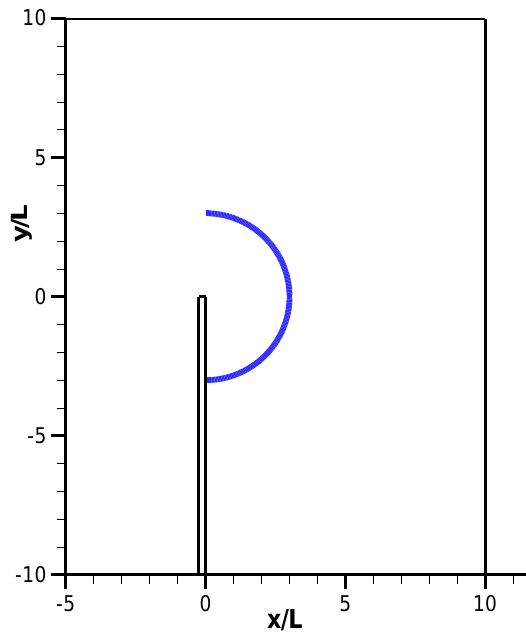
Figure 11. Layout and model domain for the diffraction modeling behind the semi-infinite breakwater (L is the wave length; blue semi-circle is the arc along which the result is compared).